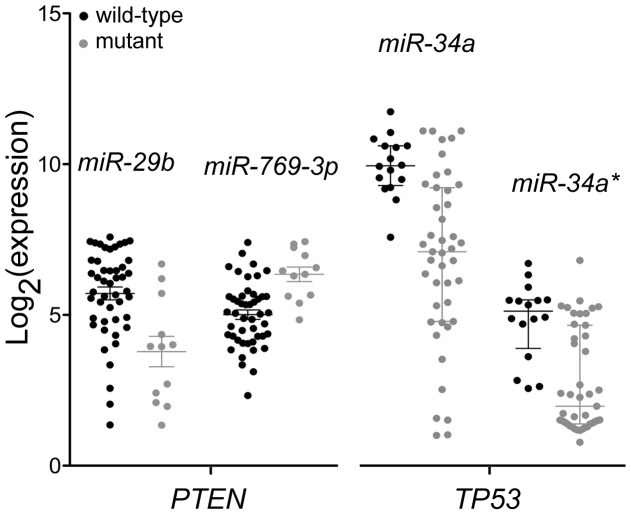
MicroRNAs and PTEN or TP53 mutations in NCI-60 cell-lines.Dot plots with medians and inter-quartile ranges are shown for the expression of microRNAs miR-29b, −34a, −34a* and −769-3p in 59 NCI-60 cell-lines grouped by mutation status for the PTEN or TP53 genes.